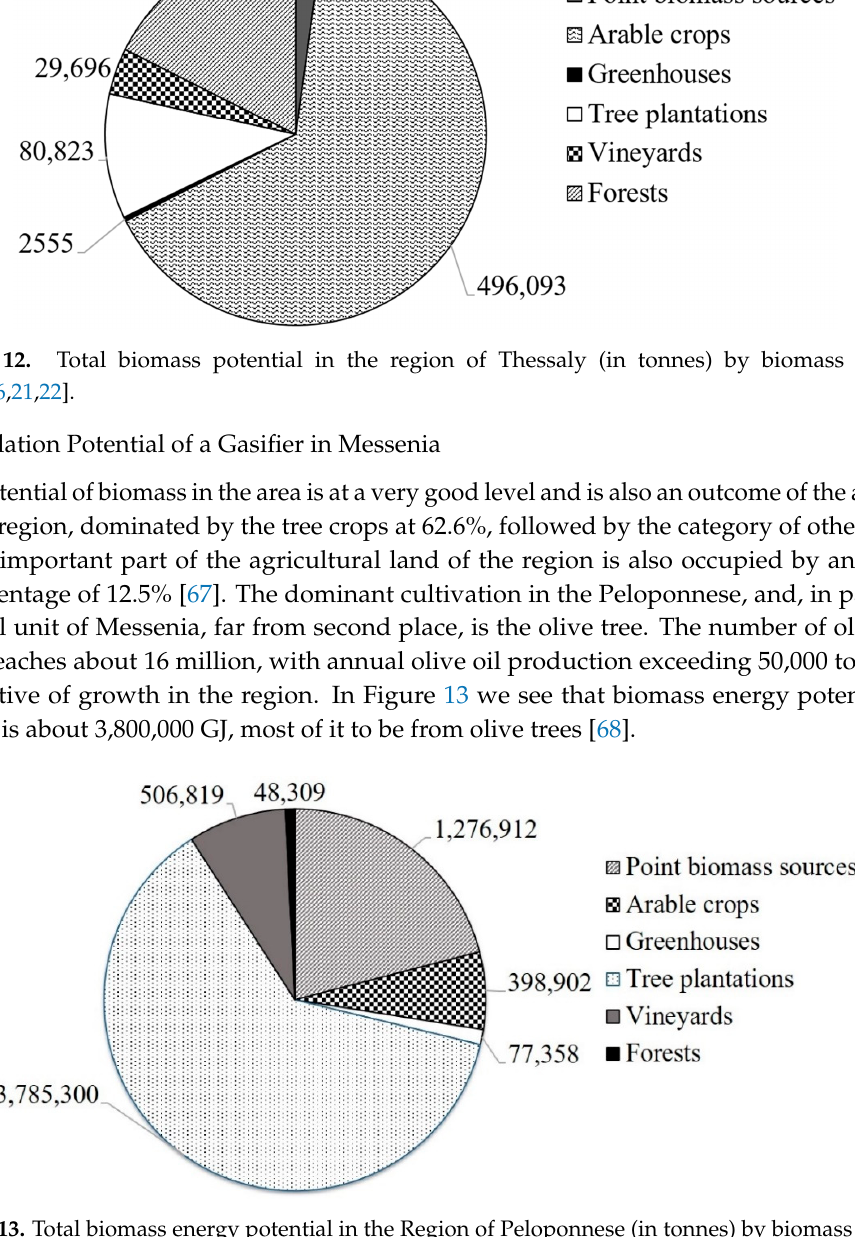
Figure 13. Total biomass energy potential in the Region of Peloponnese (in tonnes) by biomass source, 2010 [16,21,22].